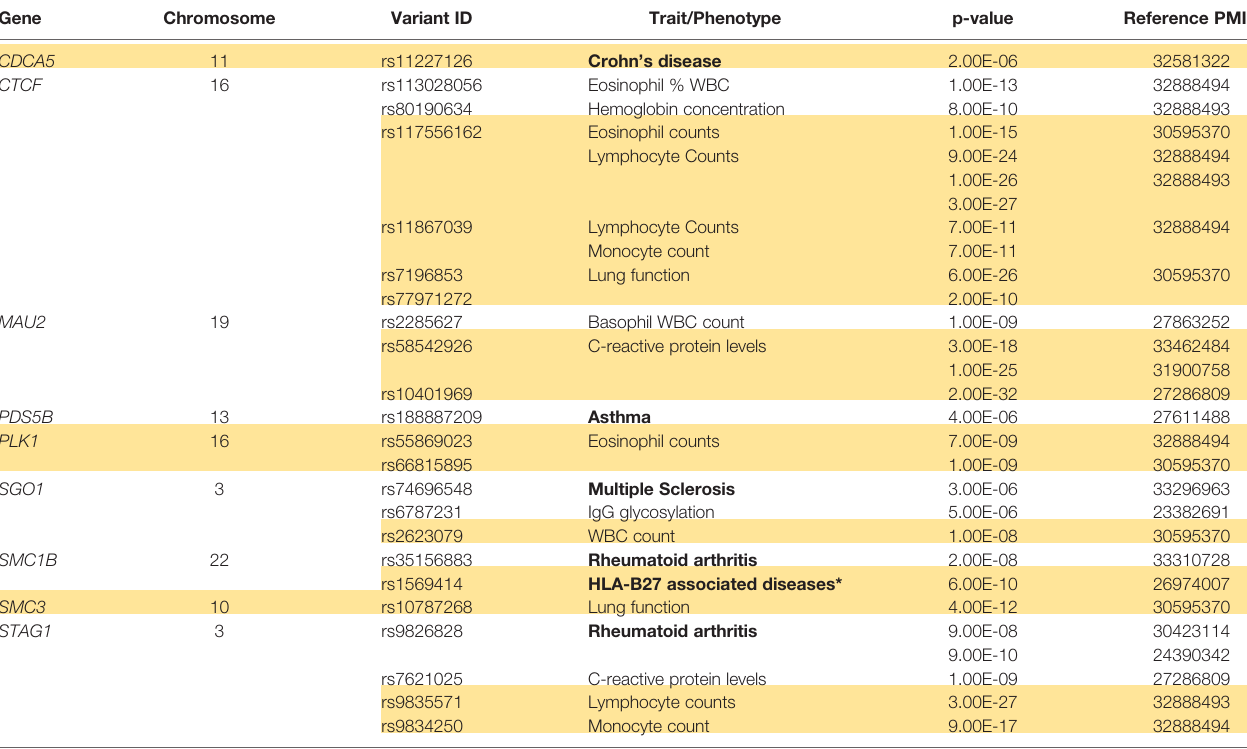
TABLE 1 | GWAS based SNPs in the cohesin complex proteins in